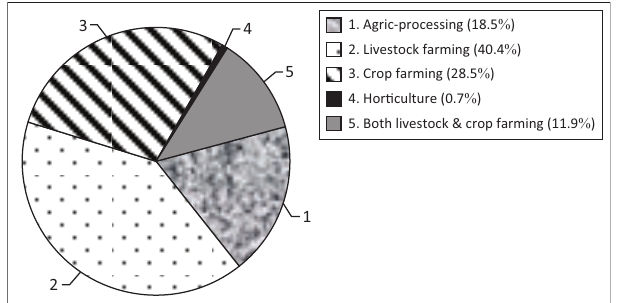
FIGURE 6: Types of business activities the SSABs practised.